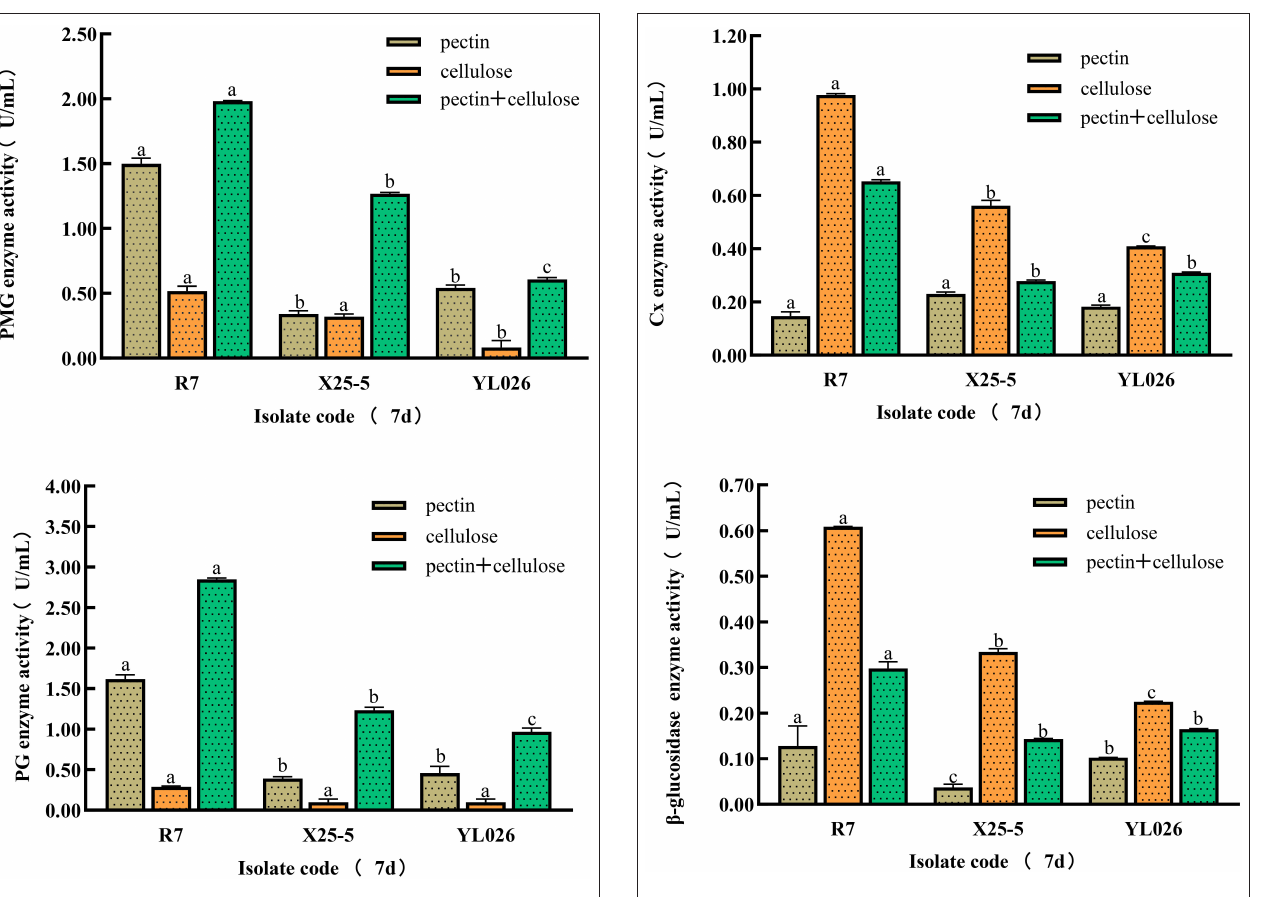
FIGURE 5 | Polymethylgalacturonase (PMG) and polygalacturonase (PG) activity in different kinds of ginseng RRR pathogen. Different letters in each column indicate statistically significant differences at the 0.05 probability level according to the Duncan test. a,b,c indicates the statistical difference without any specific meaning.